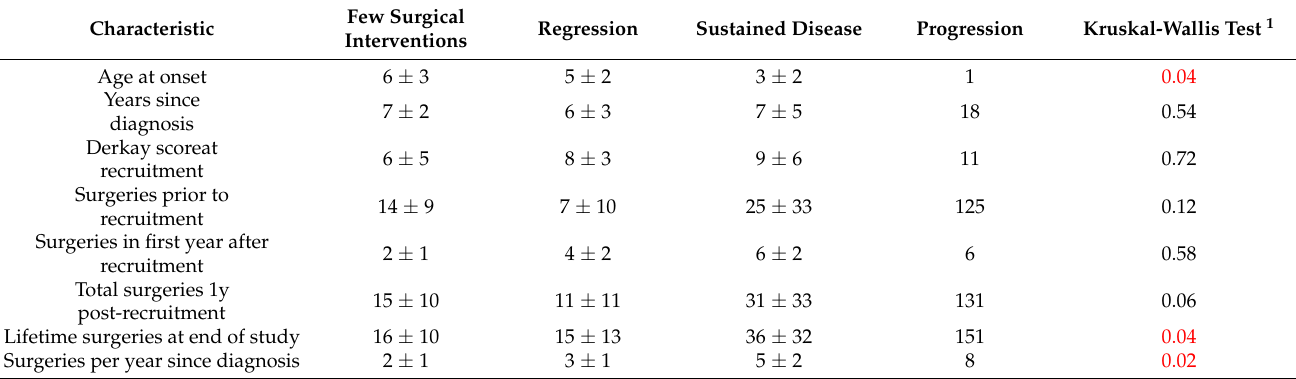
Figure 2. HPV11+ versus HPV6+ status, and not the age of onset, is associated with worse clinical course and increased severity. ( A ) Results of negative binomial regression analysis on lifetime surgeries at the end of the study period shows that white patients, males, HPV11+ patients, and patients with high Derkay scores had an increased risk of high surgical interventions, whereas patients with a later age of onset had a decreased risk of the need for surgical interventions. ( B ) The average number of surgeries per year since diagnosis and during the first year after recruitment for HPV6+ (gray) and HPV11+ (purple) patients. HPV11+ patients had increased surgeries per year since diagnosis ( p = 0.02) but not in the first year after recruitment ( p = 0.58). ( C ) Age at disease onset distribution HPV6+ and 11+ patients show an association between HPV11 positivity and earlier age at disease onset ( p = 0.04). Table 4. Summary of average values for clinical course